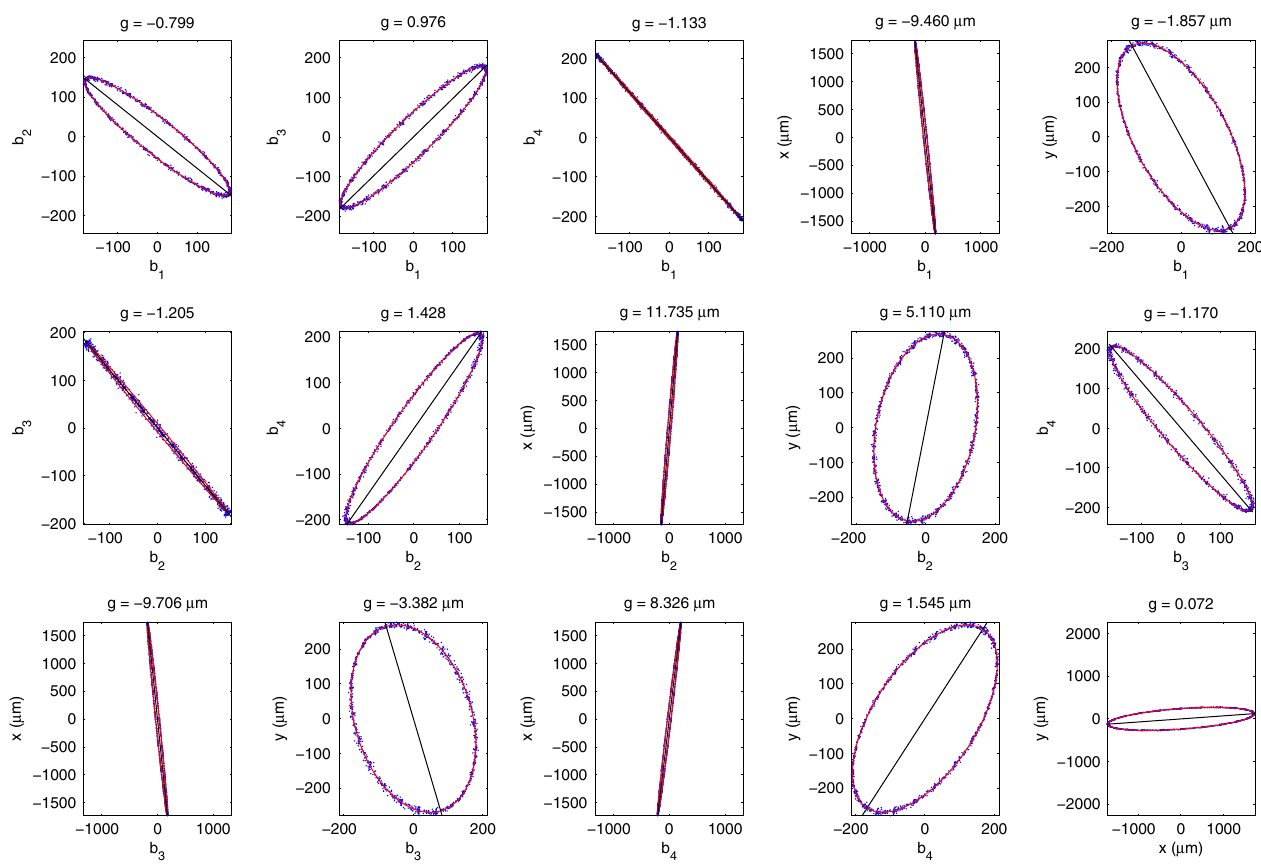
FIG. 12. Correlation plots for the button signals from BPM 7W during resonant excitation of normal mode I, with the strength of skew quadrupole 48W changed by (cid:1) k ¼ (cid:1) 0 : 023 m (cid:1) 2 . The blue points show the data from the BPM; in each correlation plot, the points are fitted with a red ellipse; the major axis of each ellipse is shown with a black line. Compare with the simulation results shown in Fig.